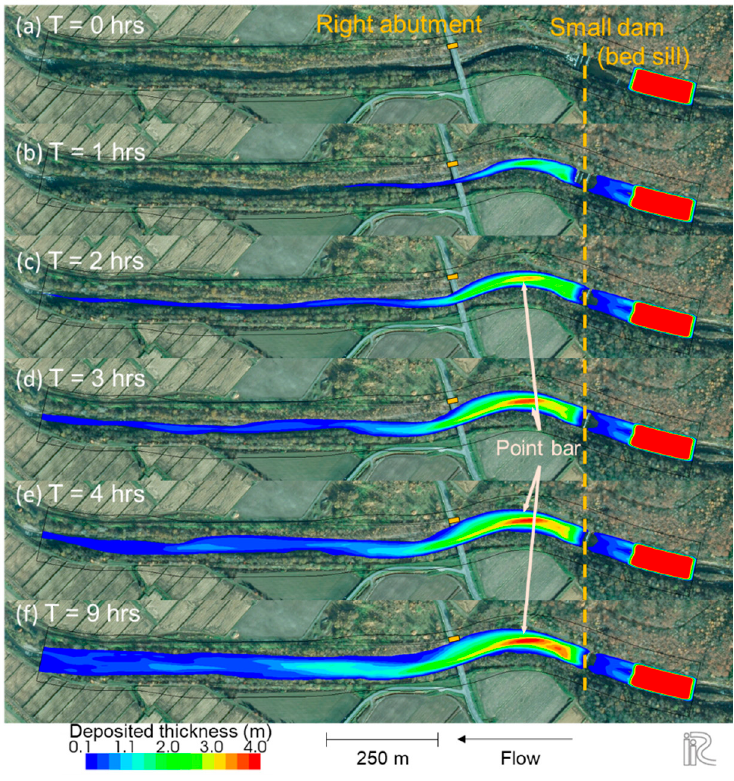
Figure 8. Temporal variation of the deposited thickness of the supplied sediments. The yellow square indicates the right abutment. indicates the right